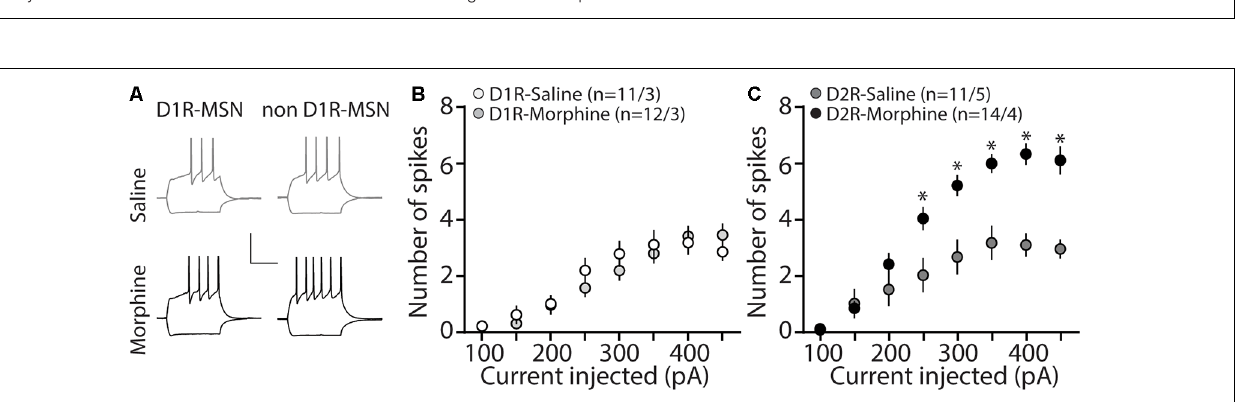
FIGURE 3 | Repeated morphine administration reduces miniature inhibitory postsynaptic current (mIPSC) frequency on D2R-MSNs on abstinence day 1. (A) Representative traces showing mIPSCs recorded from D1R- or D2R-MSNs from animals treated with saline or morphine (10 mg/kg, i.p.). Scale bar: 25 pA, 0.5 s. (B,C) Cumulative plot showing the distribution of mIPSC amplitudes recorded from D1R-MSNs (B) or D2R-MSNs (C) in animals treated with saline or morphine. (D) Summary graph showing the average mIPSC amplitude recorded D1R- or D2R-MSNs following saline or morphine treatment ( F ( 3,65 ) = 4.73, p = 0.005; one way ANOVA with Bonferroni post-test). ∗ p < 0.05. (E,F) Cumulative plot of a representative neuron showing the distribution of mIPSC inter-event intervals (I-I) recorded from D1R-MSNs (E) or D2R-MSNs (F) in animals treated with saline or morphine. (G) Summary graph showing the average mIPSC frequency recorded from D1R- or D2R-MSNs following saline or morphine treatment ( F ( 3,65 ) = 8.94, p < 0.0001; one-way ANOVA with Bonferroni post-test; ∗ p < 0.05, ∗∗ p < 0.01). (H) Summary graph showing the average rise time of mIPSC recorded from D1R- or D2R-MSNs following saline or morphine treatment. (I) Summary graph showing the average decay tau of mIPSC recorded from D1R- or D2R-MSNs following saline or morphine treatment. Circle = neuron.